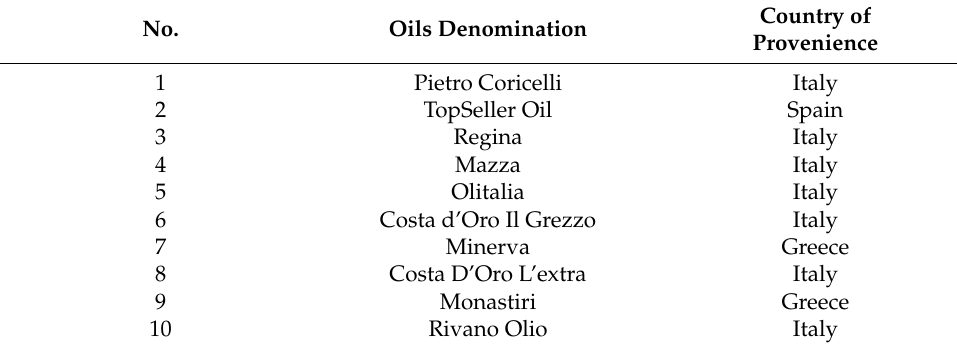
Table 8. Name and country of provenance of EVOO samples.